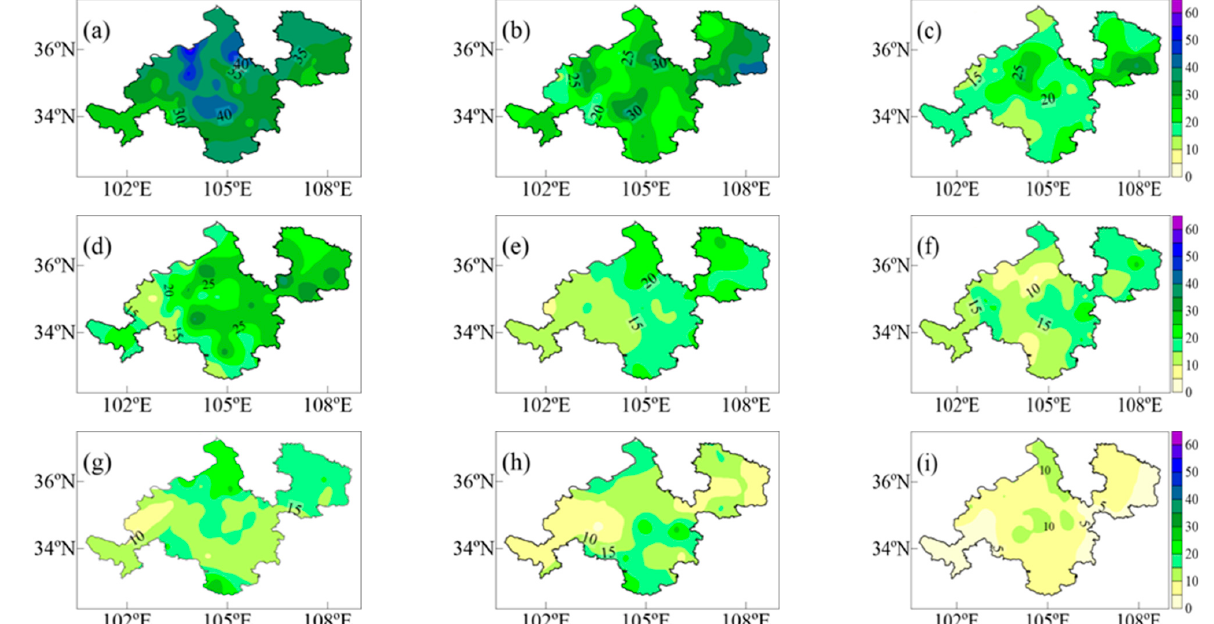
Figure 5. Frequency of different types of drought processes from 1960 to 2017 (%) (( a – d ) are intra-seasonal droughts in the following order: spring drought, summer drought, autumn drought, and winter drought; ( e – h ) are extra-seasonal droughts in the following order: spring-summer, summer-autumn, autumn-winter, and winter-spring continuous drought; and ( i ) is the drought from summer to winter).